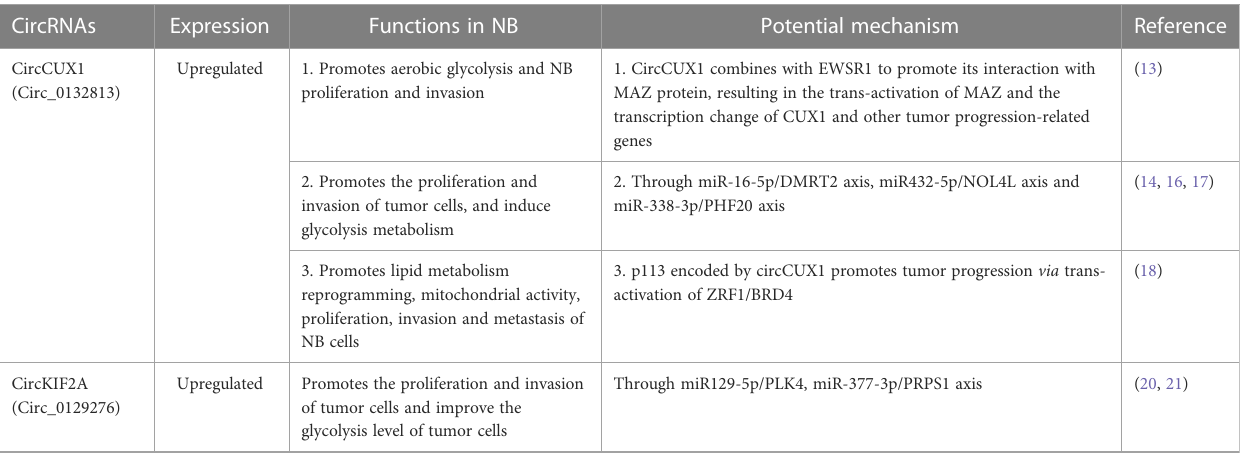
TABLE 1 Role of circRNAs in